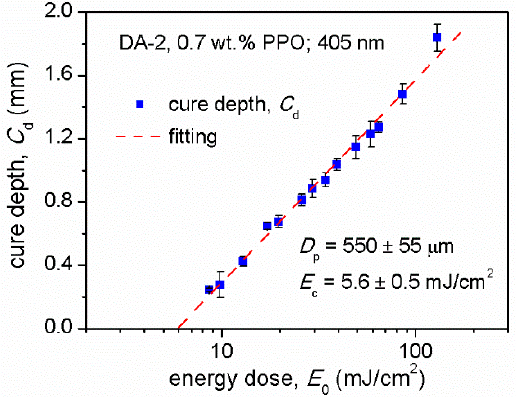
Figure 6. The working curve of the DA-2 resin.